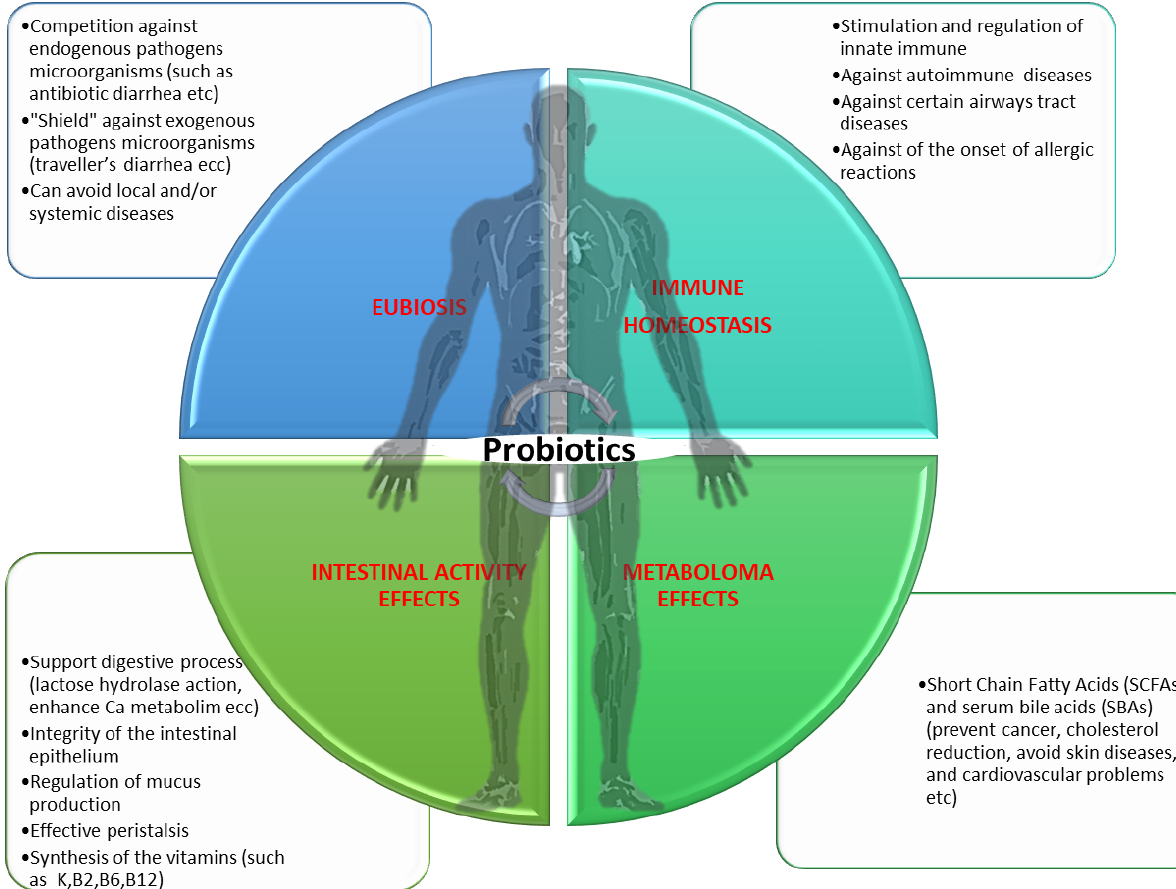
Figure 2. The human’s health benefits by probiotics strains. Credits: Original figure by I.A.